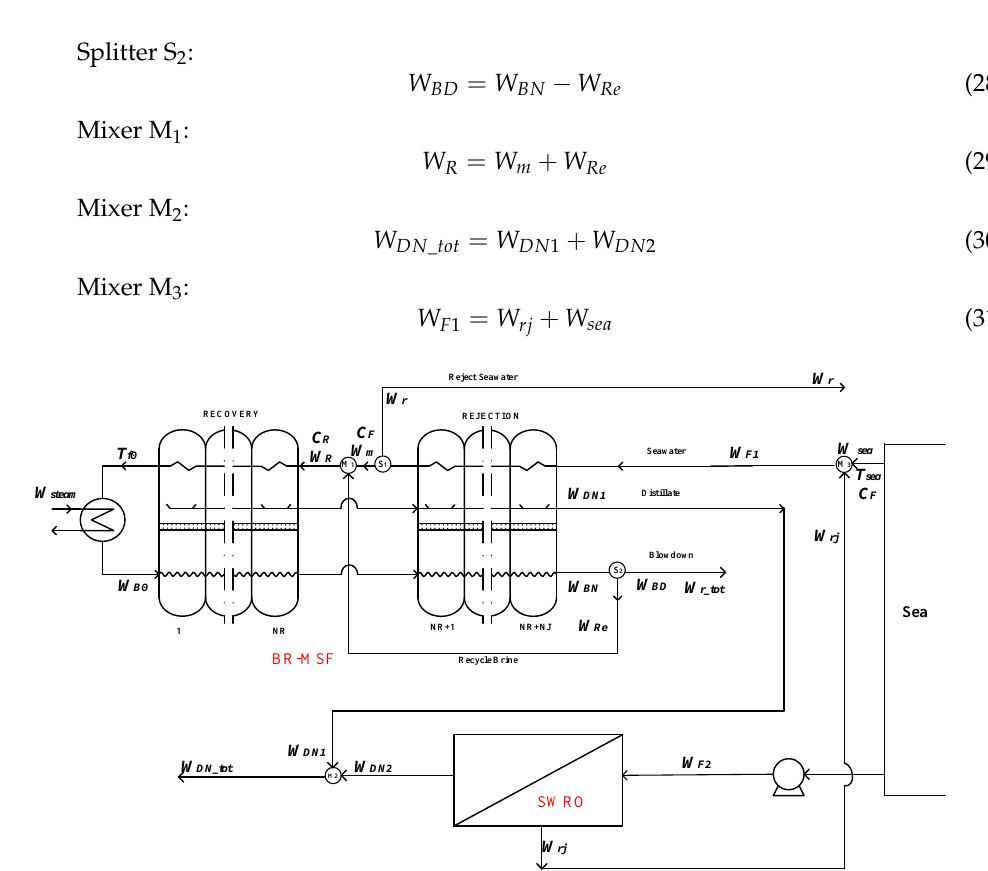
Figure 7. Option 7 — the rejected water of the SWRO system as part of the feed water of BR-MSF Figure 7. Option 7—the rejected water of the SWRO system as part of the feed water of system. BR-MSF